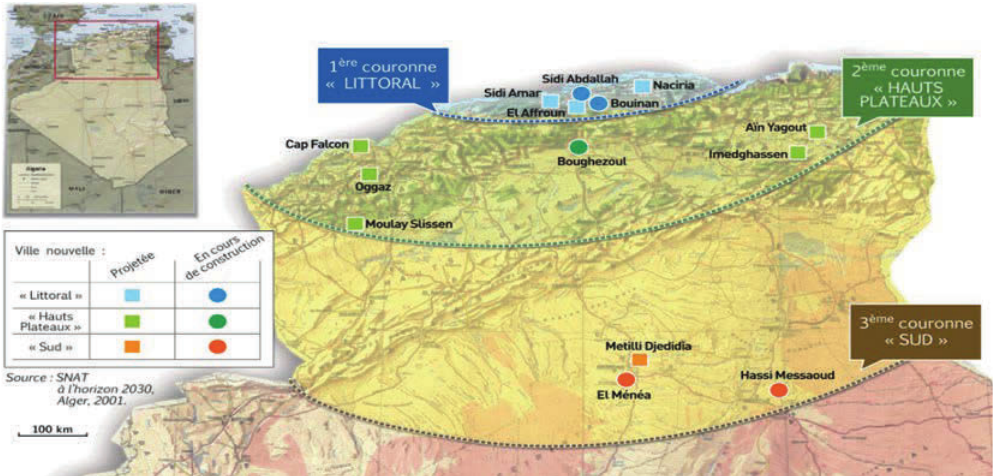
Fig. 2. The main technological poles in Algeria, National Spatial Planning Plan for 2030, Algiers, 2001 (Boumedini & Signoles,